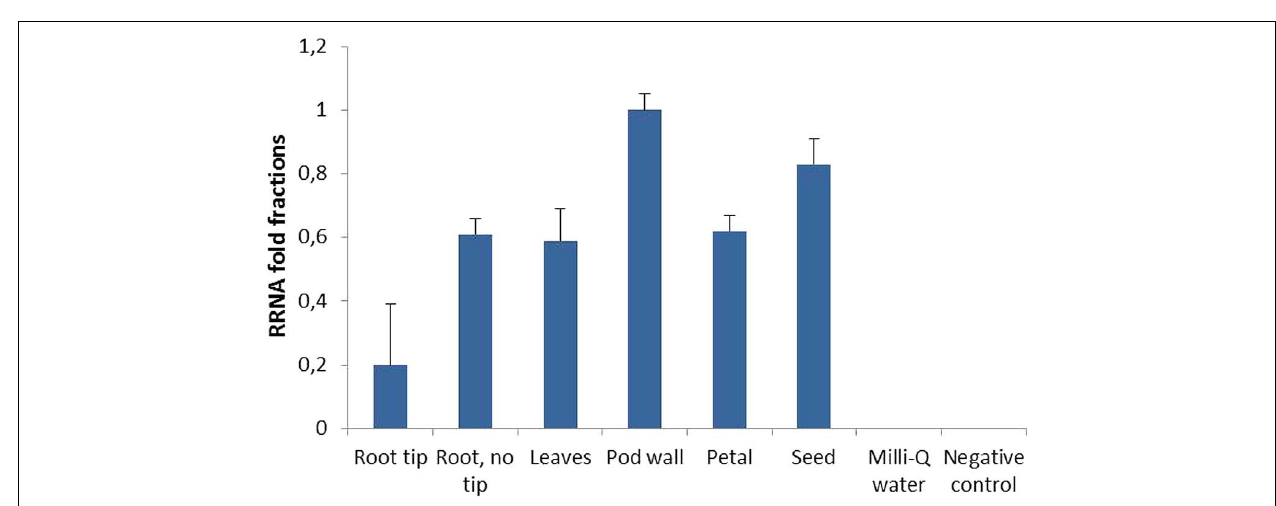
FIGURE 2 | Dry weight of seeds, pod walls, shoot (leaf and stem), and roots collected at full maturity (FM) stages ofWT and transgenic 392-3 soybean plants supplied with 10, 32, or 100 μ M of Fe(III)-EDDHA. Values